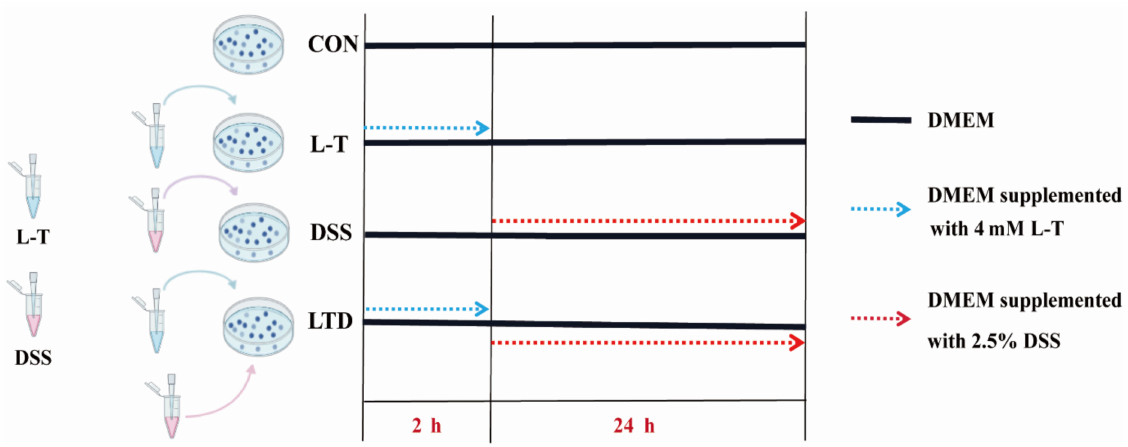
Figure 7. The test design of four treatments in this study according to the results of the CCK-8